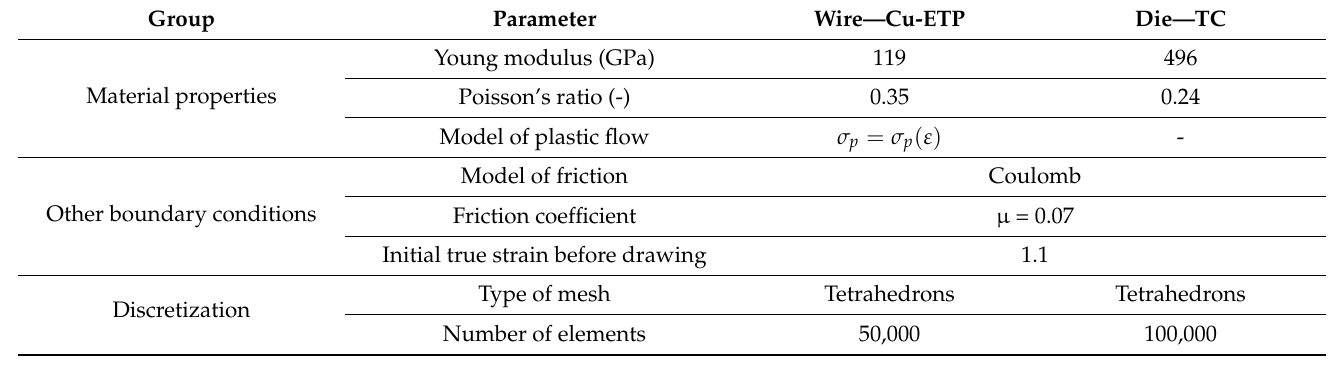
Table 2. Set of most important material boundary conditions assigned for the numerical simulation of wire drawing.